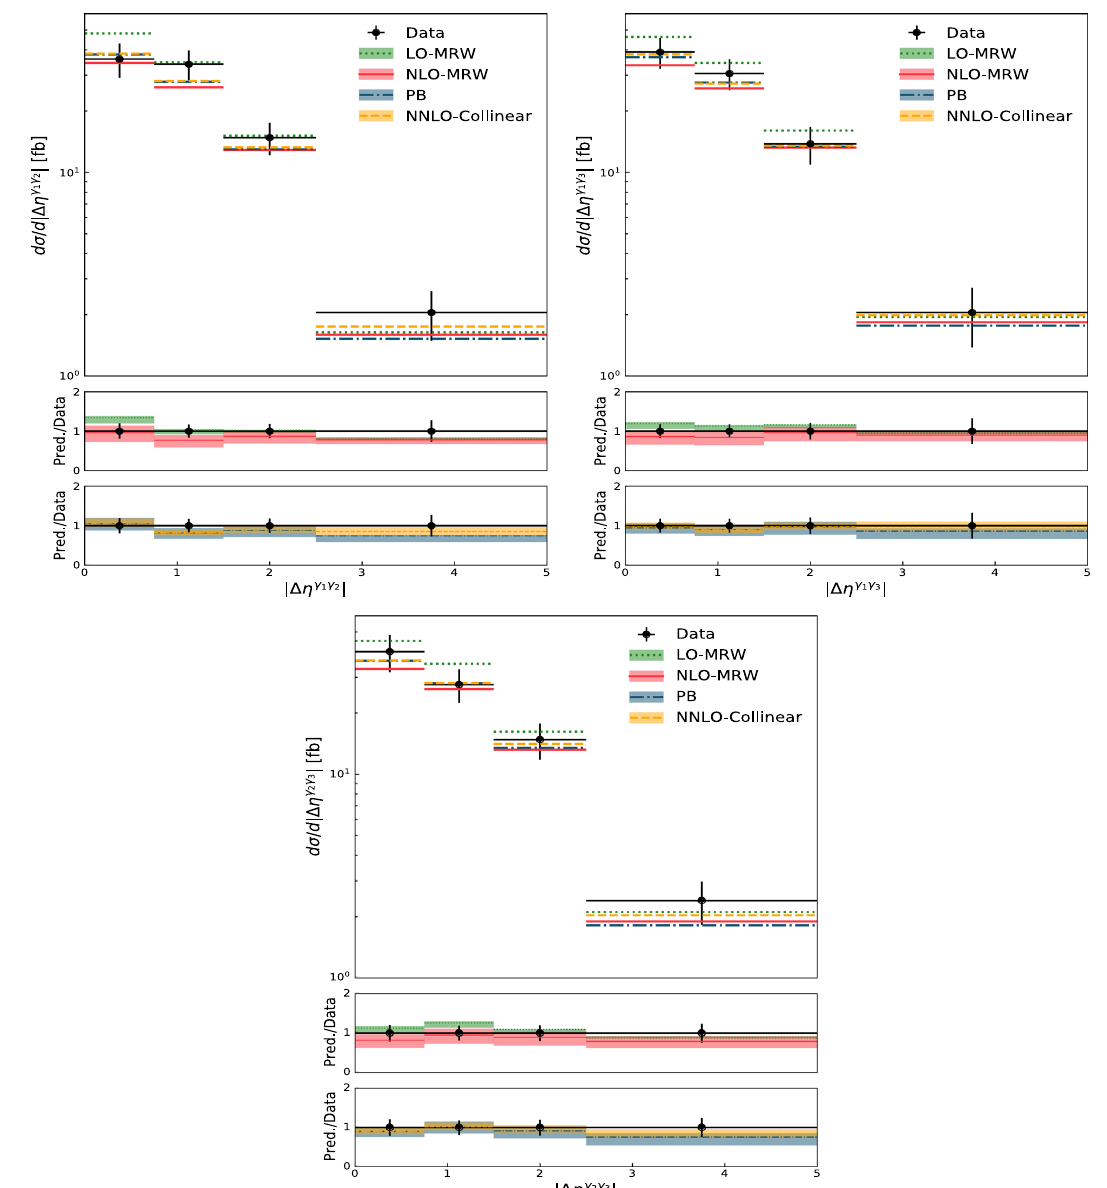
Fig. 8 The same as Fig. 7 but for absolute value of difference between pseudo-rapidities of final state